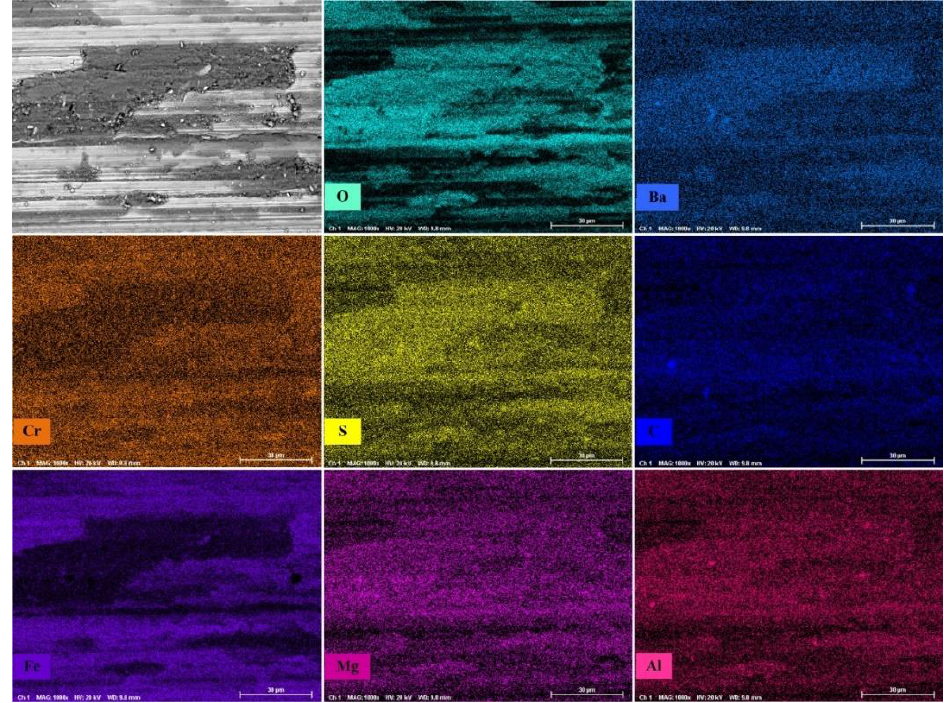
Figure 9. Element distribution X-ray maps on the worn-out surface of friction material B tested against the F55-coated disc.